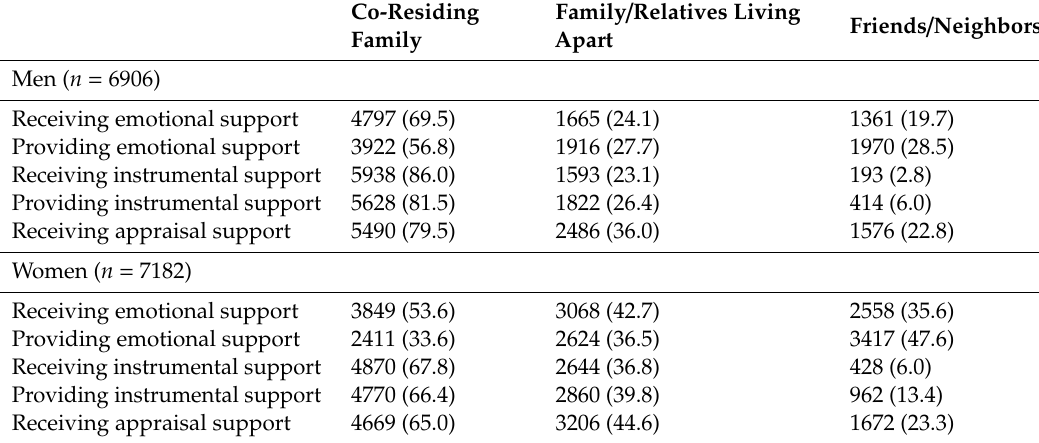
Table 2. Description of social support by type and source of support.